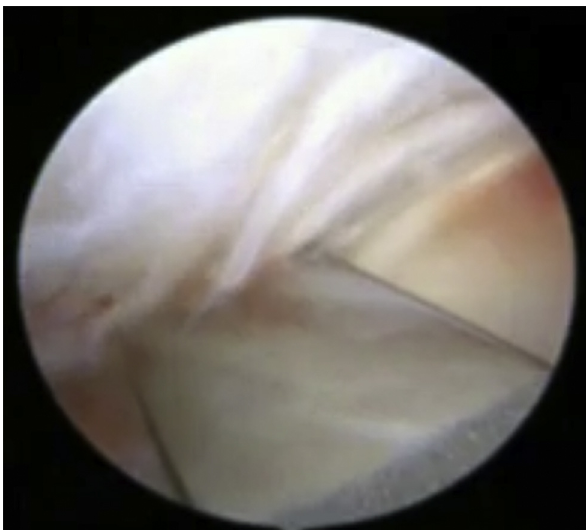
Figure 4 Instrumentation with knife, with removal of adhe- sions in the intermediate zone (between eminence and articular disk).